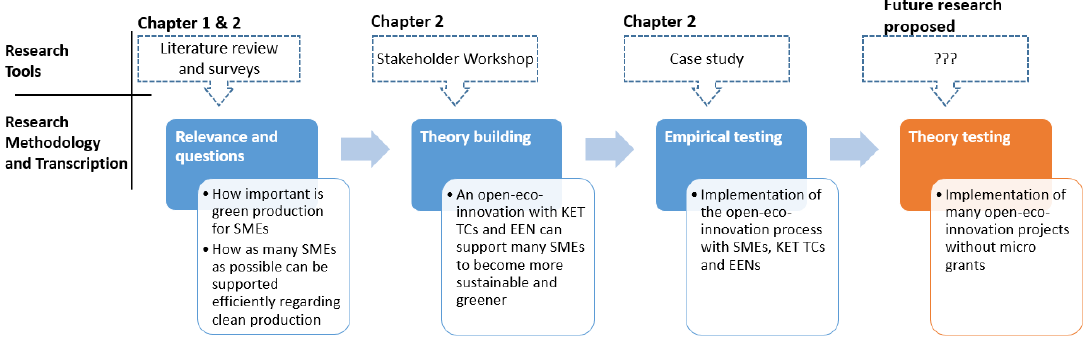
Figure 2. Design research methodology in combination with research tools .